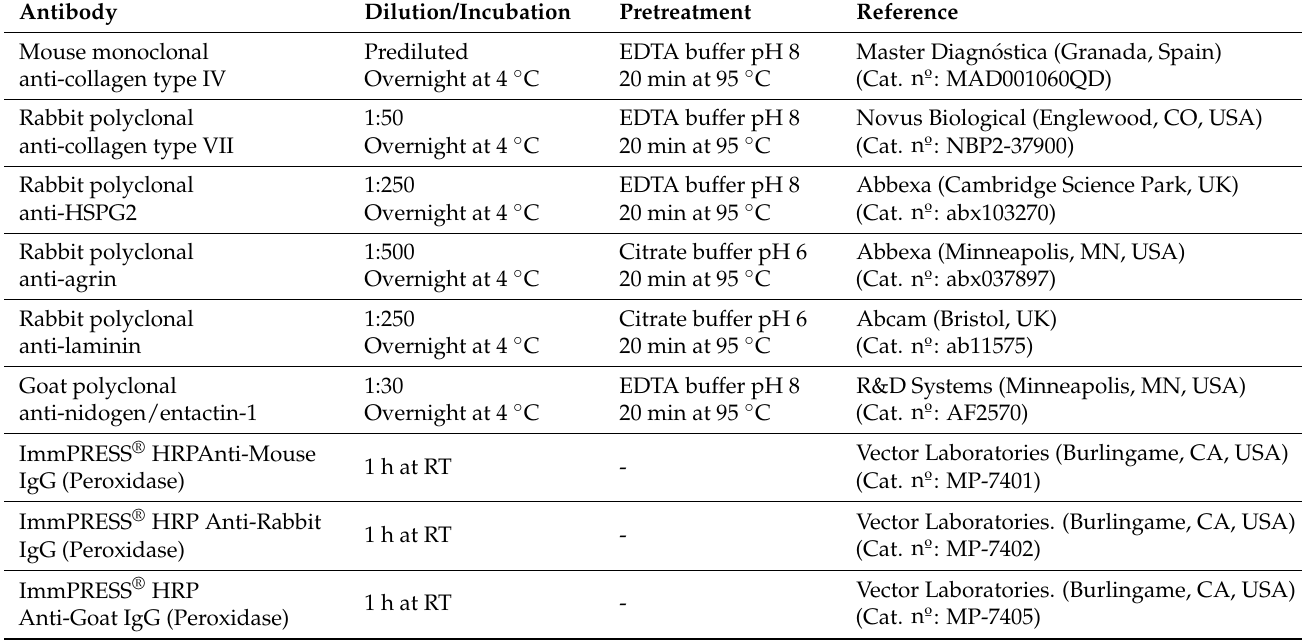
Table 1. Antibodies and technical conditions for immunohistochemical analyses. All primary anti- bodies were diluted in PBS 0.1M (pH 7.2–7.4) with 0.3% Tween-20 (Merck, Darmstadt, Germany. Cat nº : P1379).